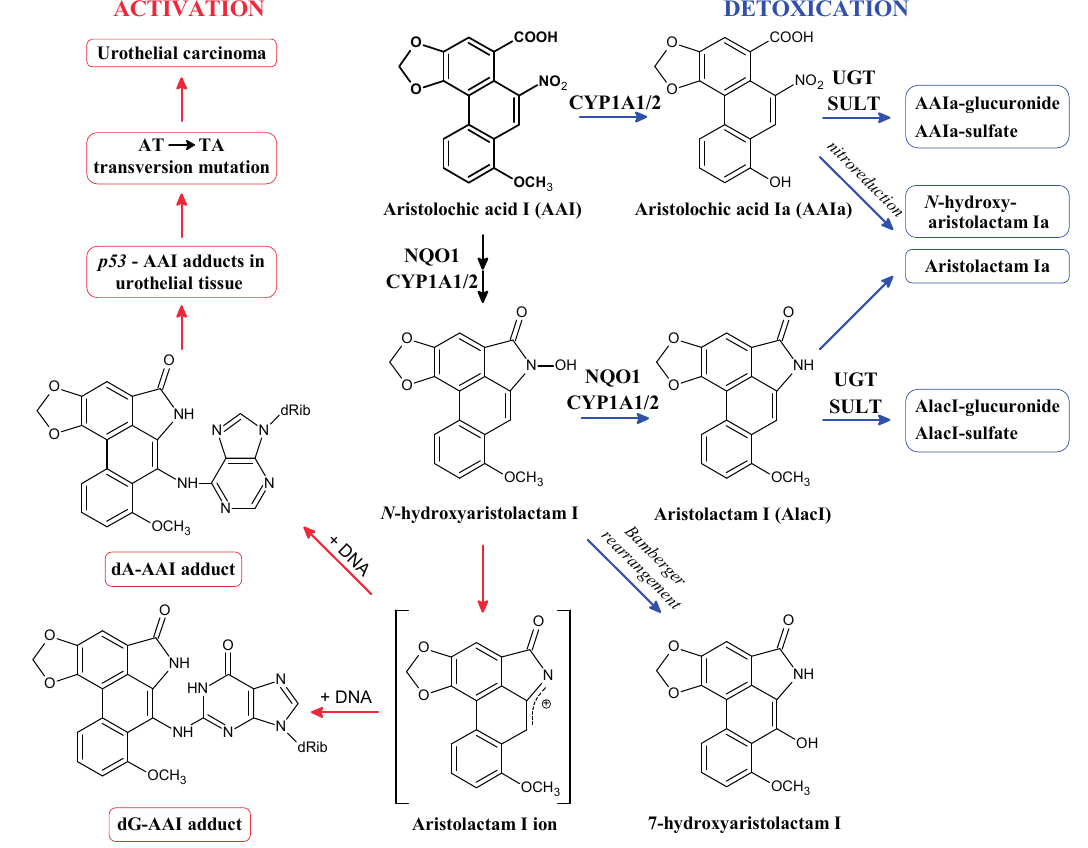
Figure 2. Activation and detoxication pathways of aristolochic acid I (AAI). dA-AAI, 7-(deoxyadenosin- N 6 -yl)aristolactam I; dG-AAI, 7-(deoxyguanosin- N 2 -yl)aristolactam I; CYP1A1/2, cytochrome P450 1A1 and 1A2; NQO1, NAD(P)H:quinone oxidoreductase; UGT, UDP glucuronosyltransferase; SULT,